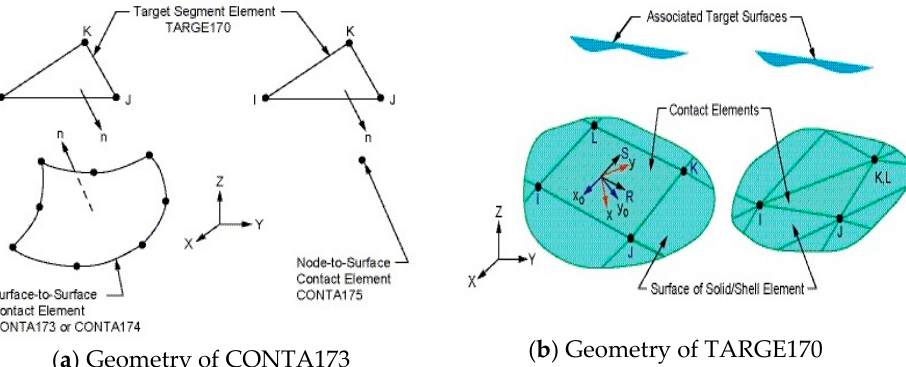
Figure 8. The geometry of interfacial contact pair elements.